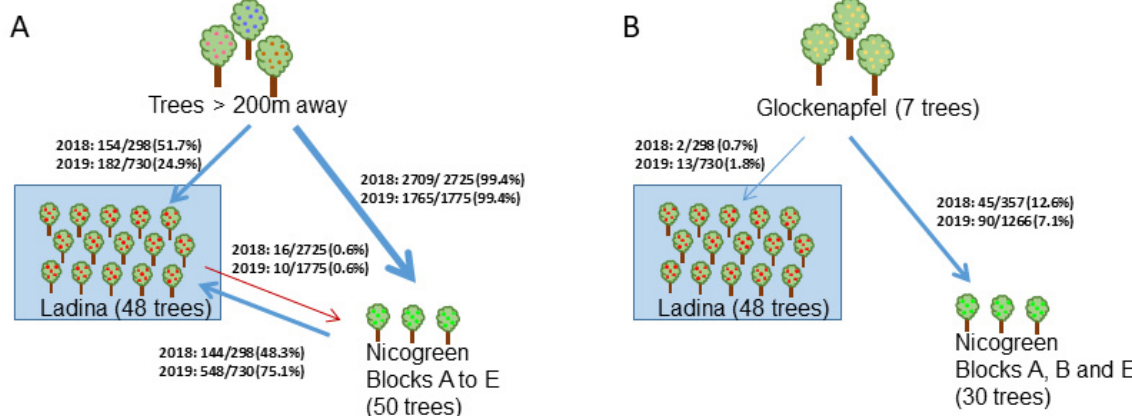
Figure 3. ( A ) Summary of the detected pollination events between ‘Ladina’ (in Block 0, blue box) and ‘Nicogreen’ (in Blocks A to E outside the netted Block 0), as well as those between unknown trees with ‘Ladina’ and ‘Nicogreen’. The ‘Glockenapfel’ pollinations are included in the “trees >200 m away” group. ( B ) Summary of the detected pollination events between ‘Glockenapfel’ and ‘Ladina’ as well as ‘Glockenapfel’ and ‘Nicogreen’ (Blocks A, B, and E). ‘Glockenapfel’ trees are located approximately 300 m from the centre of Block 0. The pollination events are displayed per year and as fractions of seedlings with full SSR dataset. Arrow thickness represents importance of the pollination route. The red arrow indicates the ‘Ladina’ outcrossing events.